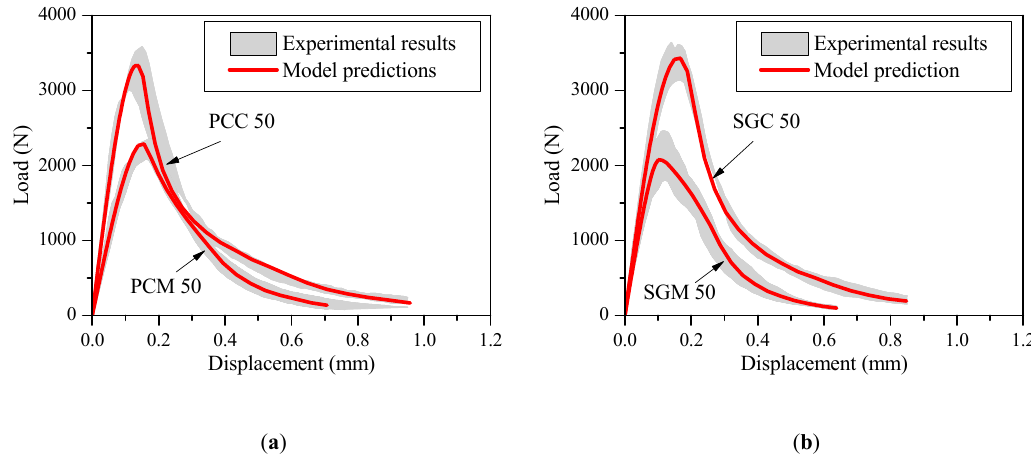
Figure 4. P-d curves obtained from experiment and prediction ( a ) PC mortar and concrete and ( b ) SG mortar and concrete.